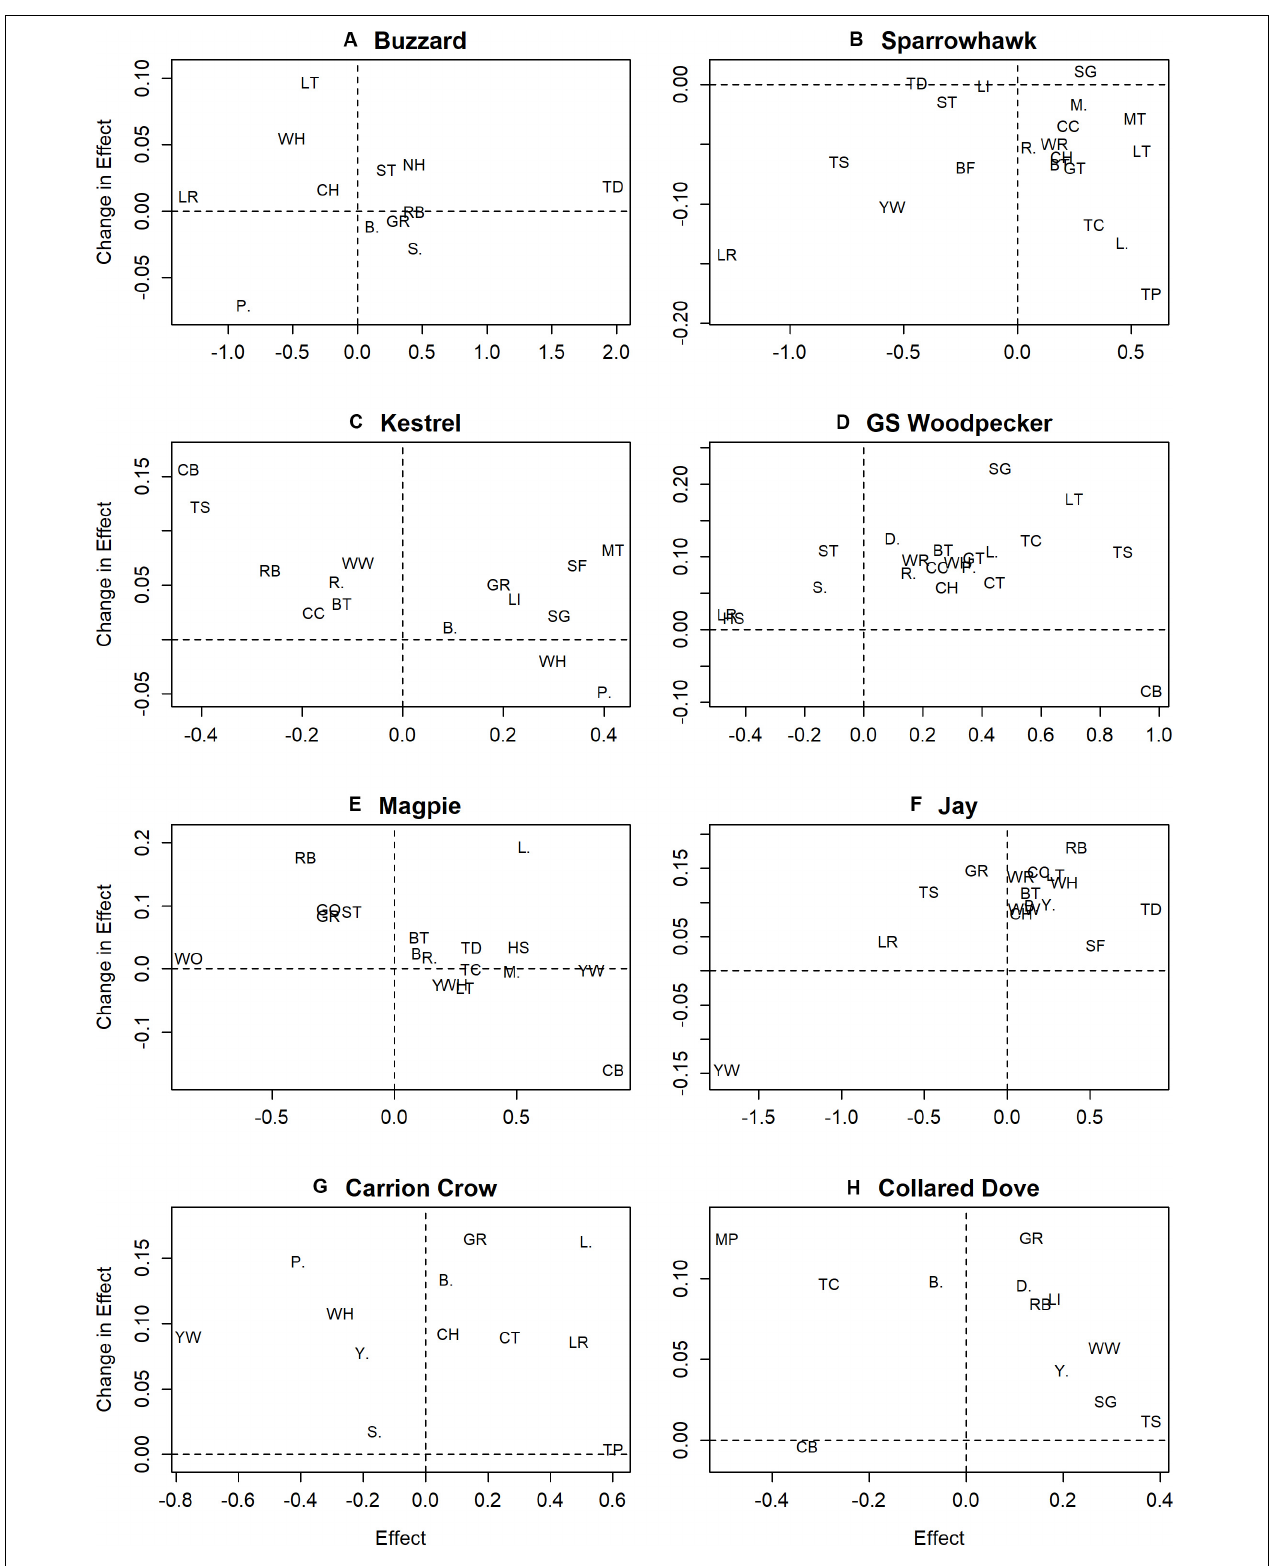
FIGURE 2 | Plots of change in predator effect on deletion of biomass from the linear model against predator effect prior to deletion. Parts (A–H) show changes in effects of individual predators on prey species where the effect is significant prior to biomass deletion, with prey species denoted using standard British Trust for Ornithology codes (see Supplementary Table S1